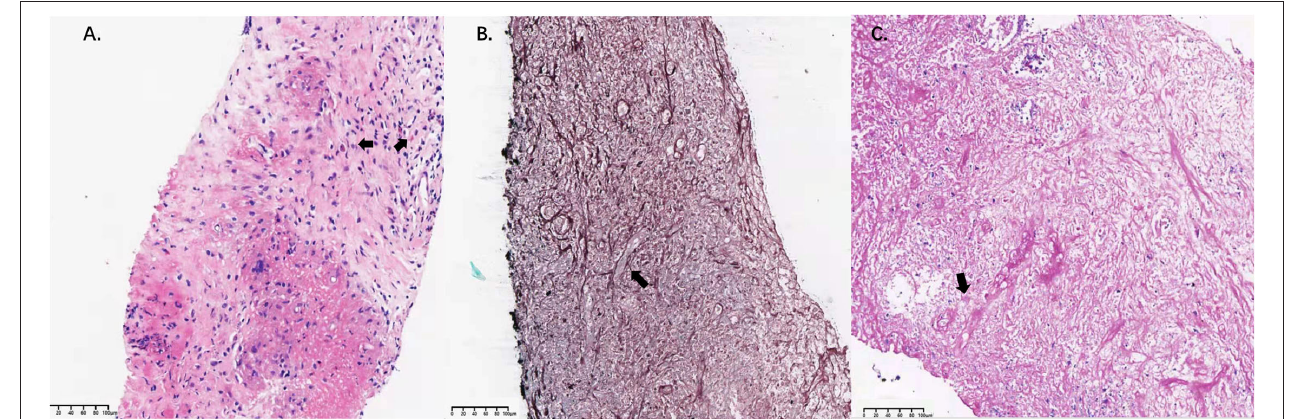
FIGURE 2 | Pathological findings in lung tissue samples. (A) High-magnification image of a hematoxylin-eosin-stained specimen (bar = 100 µ m). Infiltration of eosinophils was observed (arrow). (B) Gomori’s methenamine silver staining revealed filamentous fungi with broad and nonseptate hyphae in the lung lesion (arrow; bar = 100 µ m). (C) Periodic acid Schiff staining revealed filamentous fungi with broad and nonseptate hyphae in the lung lesion (arrow; bar = 100 µ